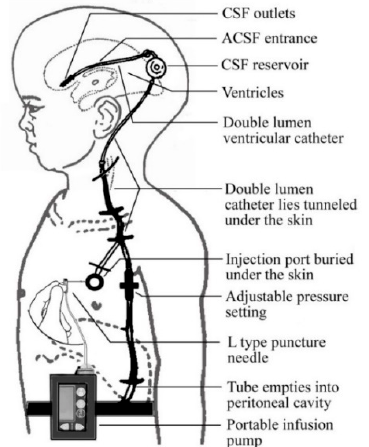
Figure 3. Diagram of cerebrospinal fluid (CSF) Circulation Assistant Device [45]. ACSF = artificial CSF.